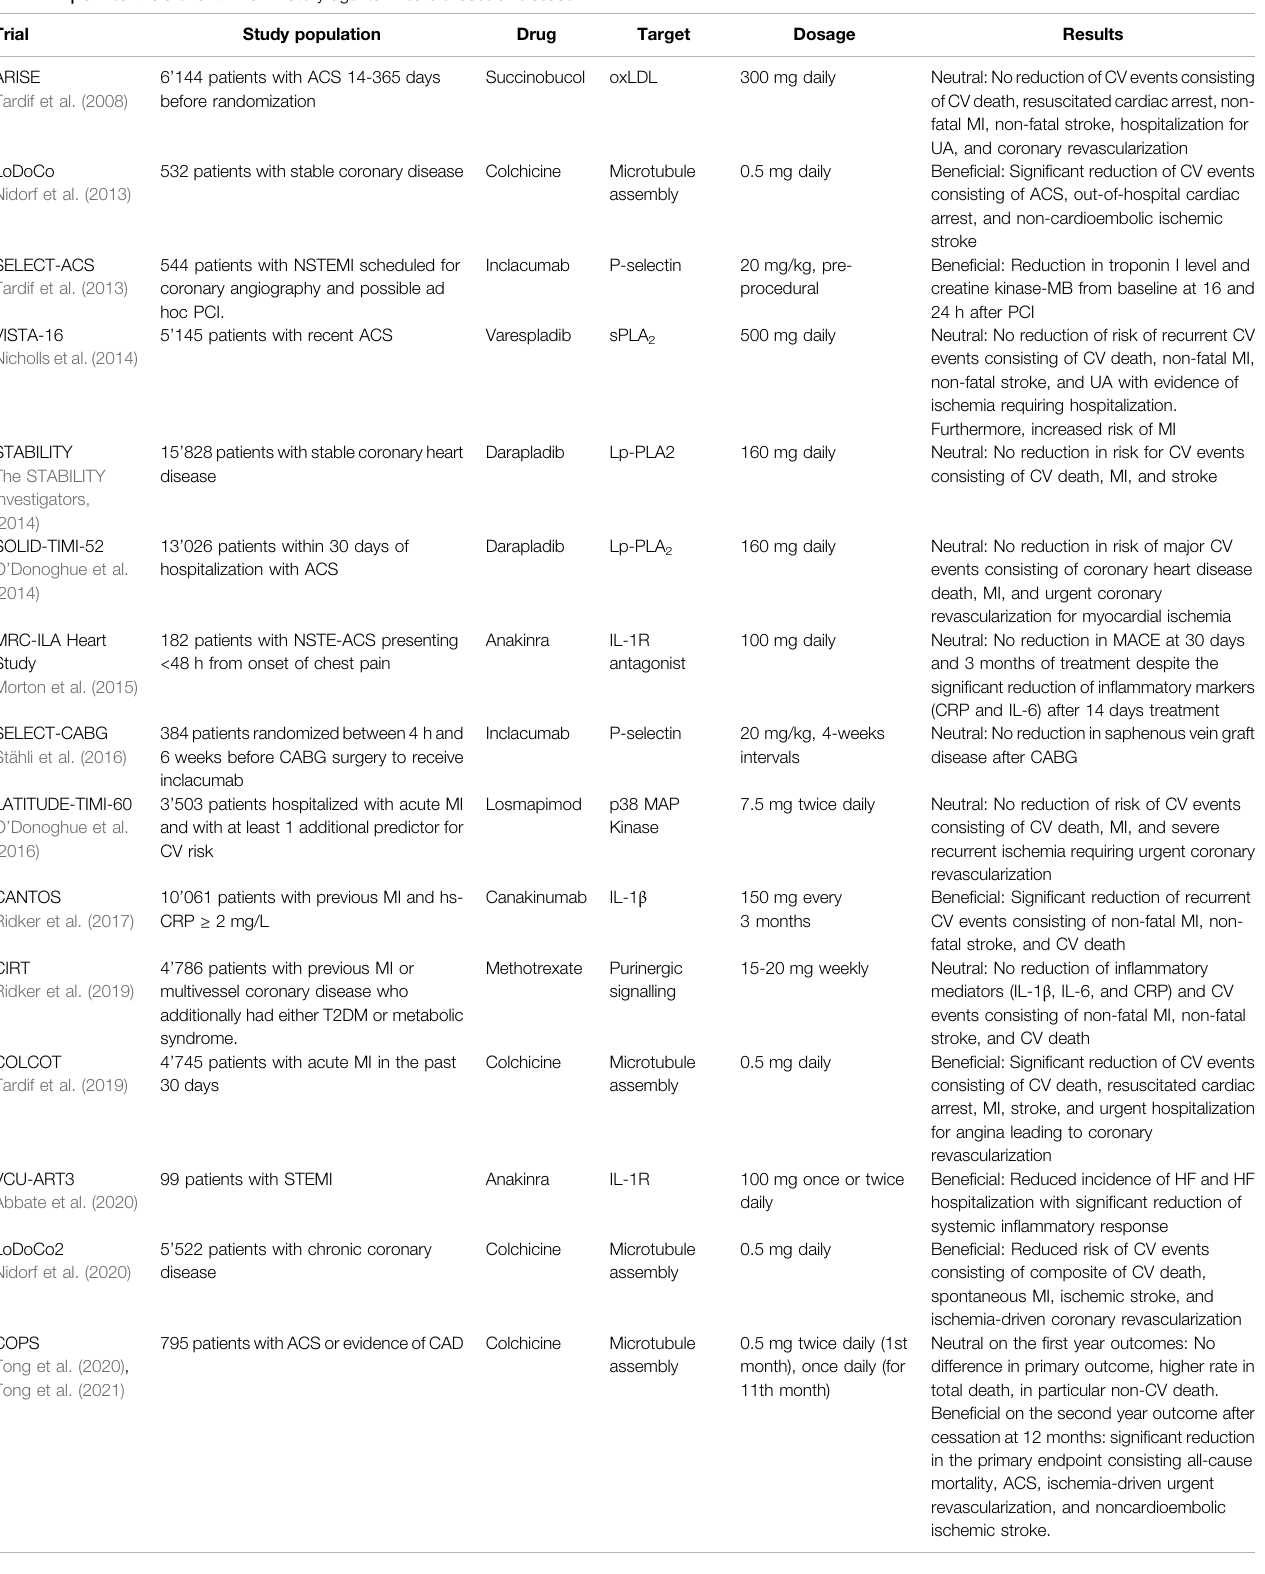
TABLE 1 | Clinical trials of anti-in fl ammatory agents in cardiovascular